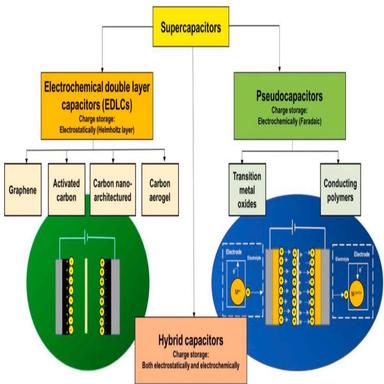
Classification of SCs according to material used for electrode. Reproduced from Ref. ..